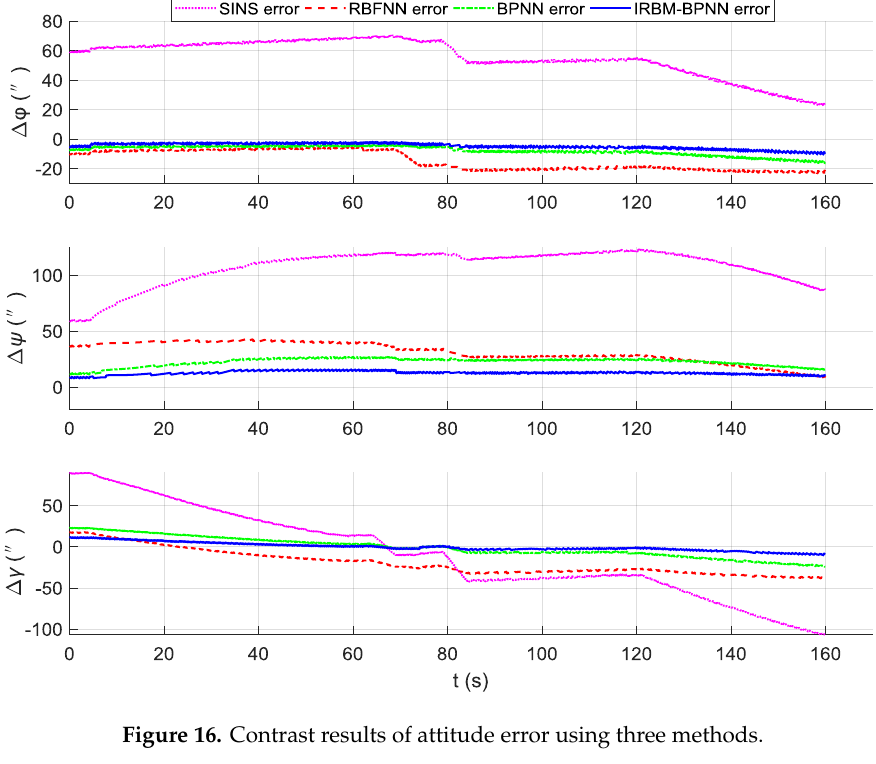
Figure 16. Contrast results of attitude error using three methods.